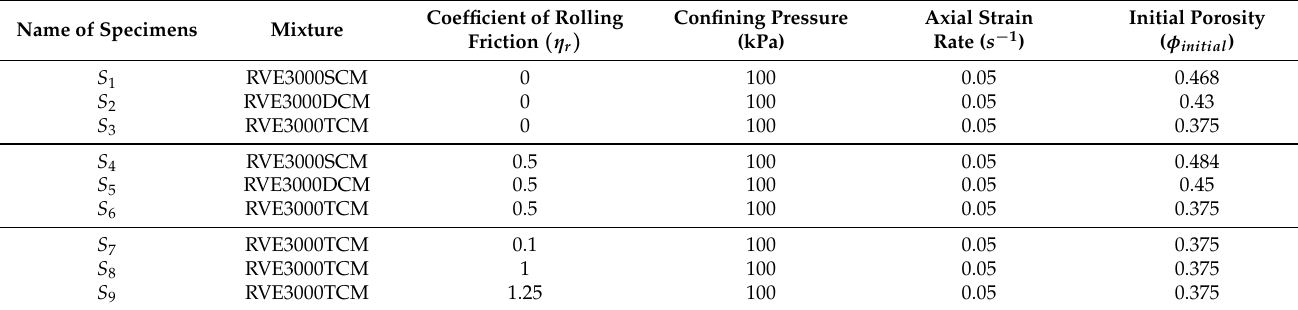
Table 3. The characteristic of the specimens used to investigate the effects of particle size distribution and rolling resistance on the mechanical behavior of coke